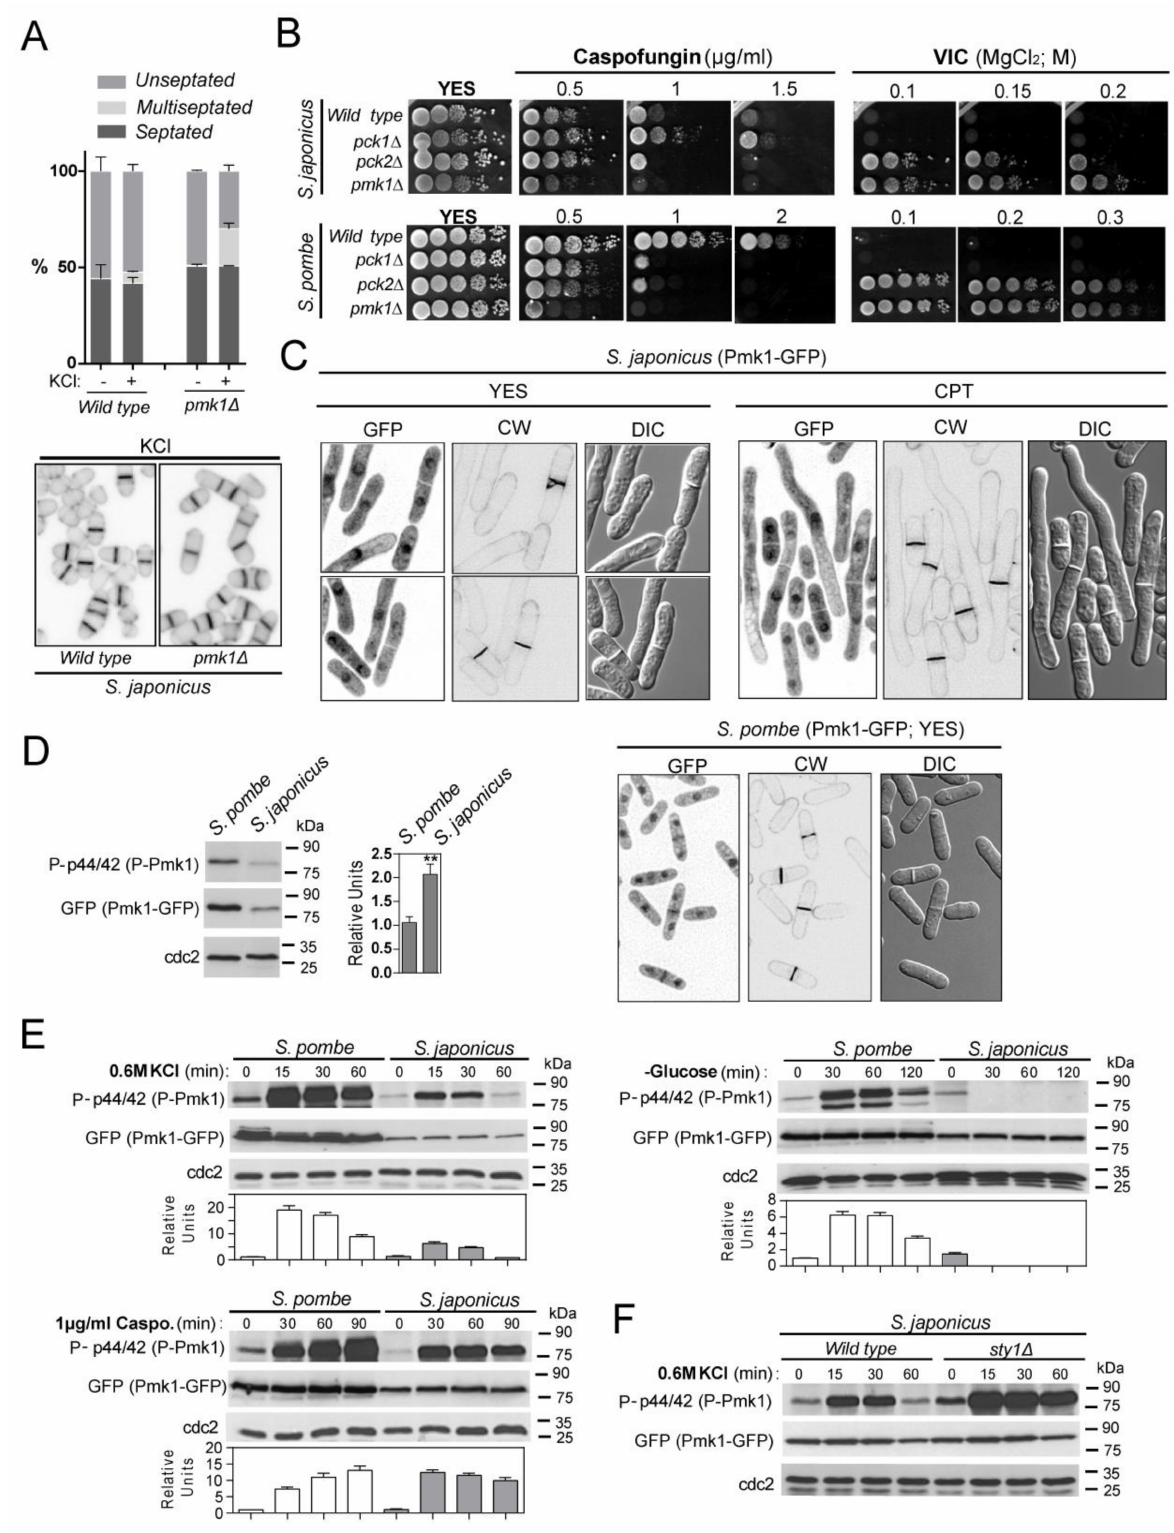
Figure 1. Functional roles, localization, and activation pattern of the CIP MAPK Pmk1 in S. japonicus. ( A ) Upper : Exponen- tially growing S. japonicus wild-type and pmk1 ∆ strains were incubated for 10 h in YES medium plus 0.6M KCl, and the percentage of unseptated, septated, and multiseptated cells (represented as mean ± SD from biological triplicates;